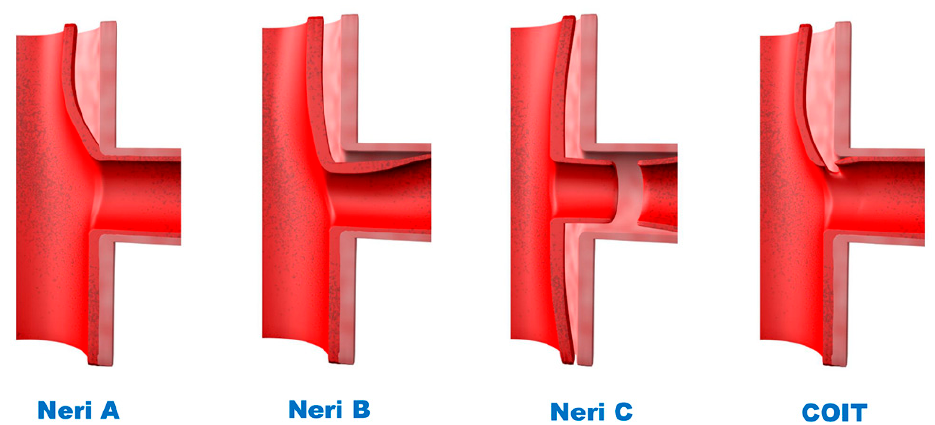
Figure 1. A modified Neri Classification of CM due to ATAAD. CM, coronary malperfusion; ATAAD, acute type A aortic dissection; COIT, coronary ostium intimal